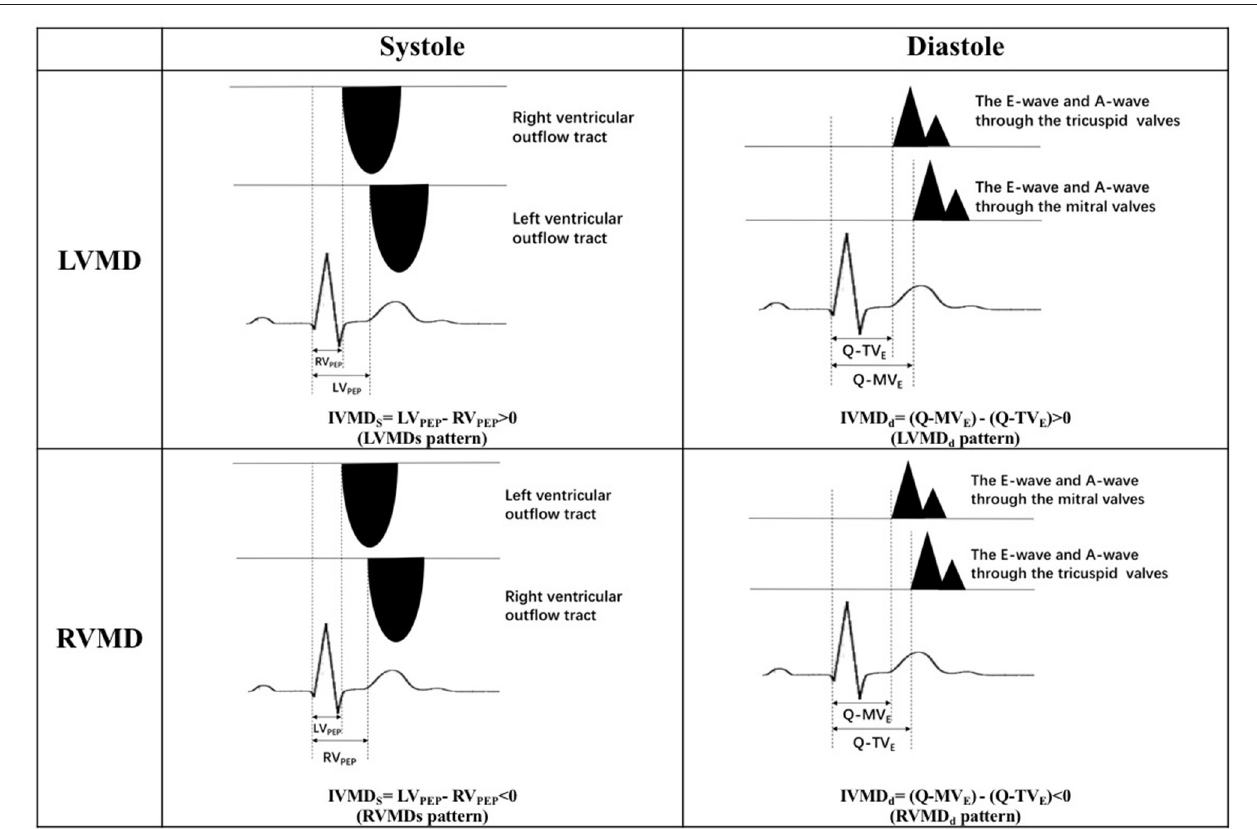
FIGURE 1 | Four mechanical delay patterns. LVMDs, left ventricular mechanical delay in systole; RVMDs, right ventricular mechanical delay in systole; LVMDd, left ventricular mechanical delay in diastole; RVMDd, right ventricular mechanical delay in diastole; IVMDs, systolic interventricular mechanical delay; IVMDd, diastolic interventricular mechanical delay; LV PEP , left ventricular pre-ejection period; RV PEP , right ventricular pre-ejection period; Q-MVe, the time interval from the onset of QRS complex to the onset of the early diastolic E wave of the mitral valve; Q-TVe, the time interval from the onset of QRS complex to the onset of the early diastolic E wave of the tricuspid